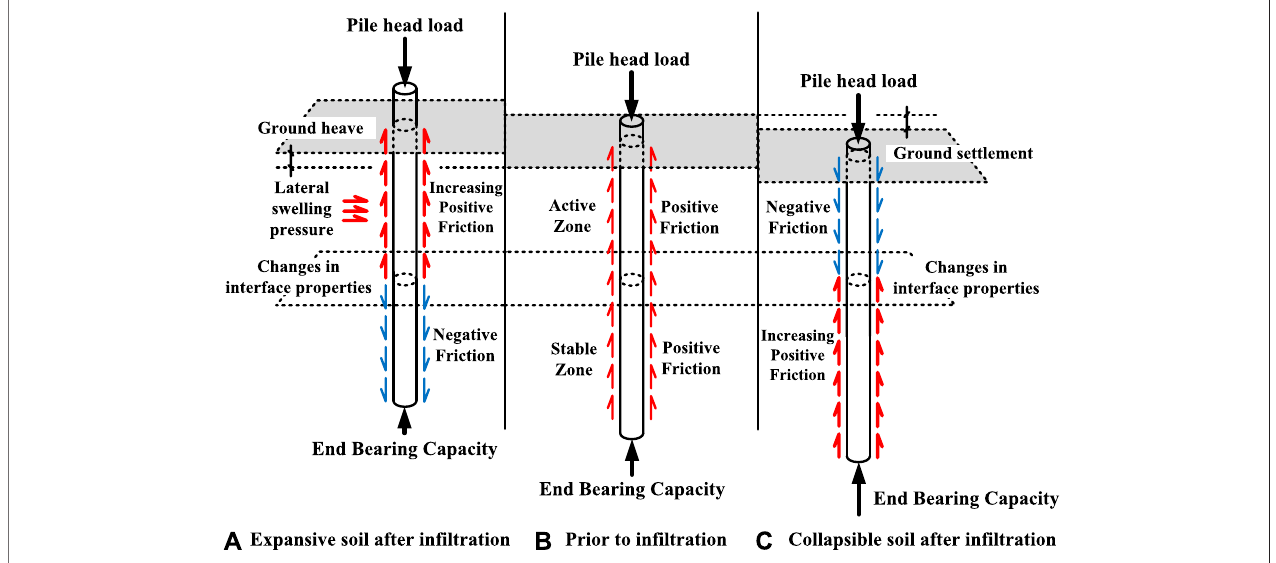
FIGURE 1 | Load transfer mechanism variations of piles in unsaturated problem soils with signi fi cant volume changes upon in fi ltration. (A) Expansive soil after in fi ltration. (B) Prior to in fi ltration. (C) Collapsible soil after in fi ltration.